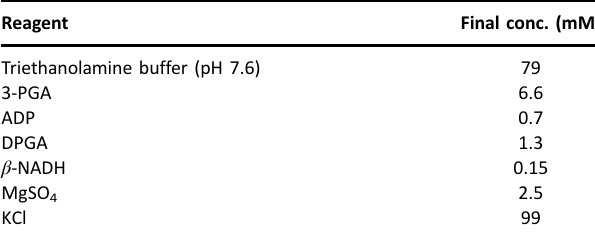
Table 4. Reagents for iPGM